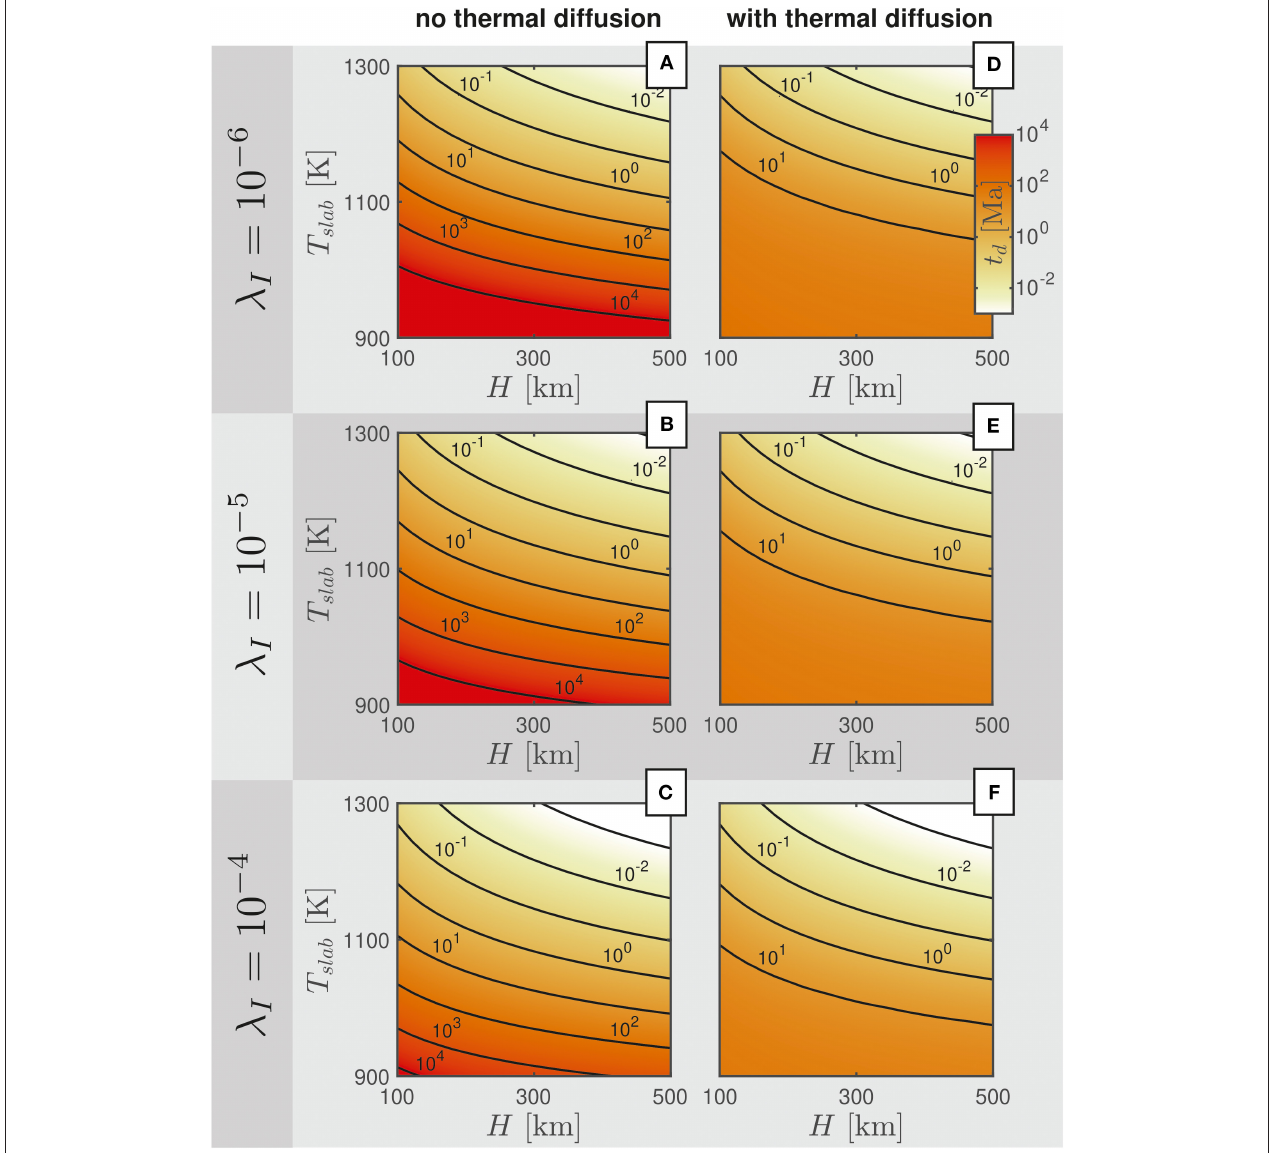
FIGURE 9 | Application to Earth. Detachment times t d for a range of slab lengths H and mean slab temperatures T slab . Detachment times were computed using the parameters listed in Table 1 . (A–C) Detachment times computed with three different values for λ I , neglecting thermal diffusion. (D–F) Same as (A–C) , but with thermal diffusion